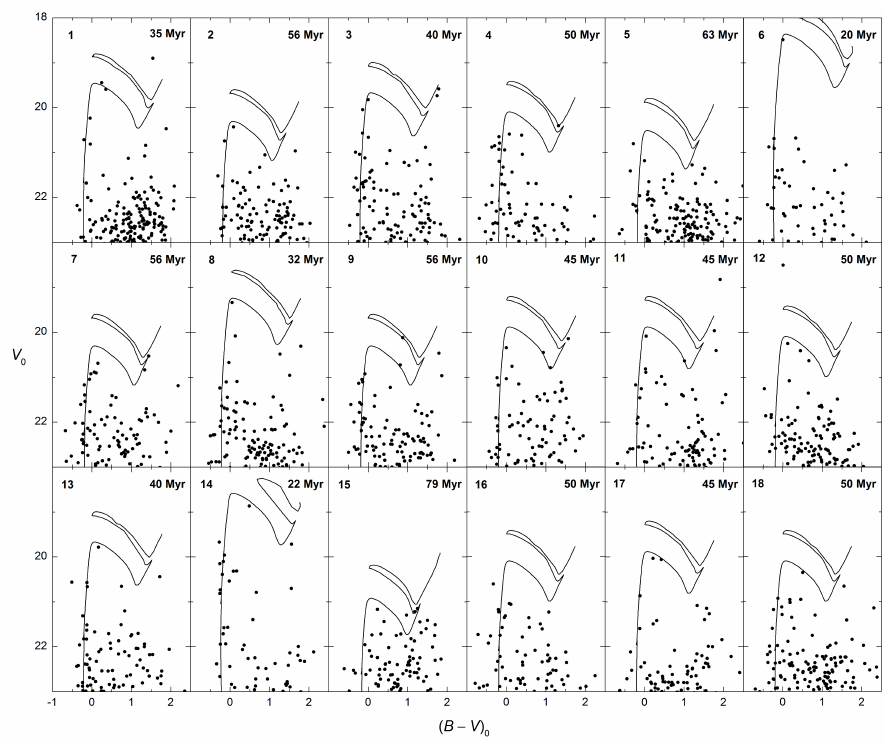
Fig. 2. The color-magnitude diagrams of the oldest stellar populations in the super- shells (stars enclosed within the white contours in Fig. 1c), with PARSEC isochrones of Z = 0 . 005 overlaid. Stellar photometry data (black dots) are from Narbutis et al. (2016, in preparation). Indicated in each panel are the supershell’s ID number (Fig. 1b) and the estimated age (i.e., the age of the plotted isochrone). All isochrones are shifted by a distance modulus of 24.65 mag (Stonkut˙e et al. 2008). Stars are de-reddened according to the foreground MW extinction E ( B − V ) = 0 . 06 mag (Schlegel et al.